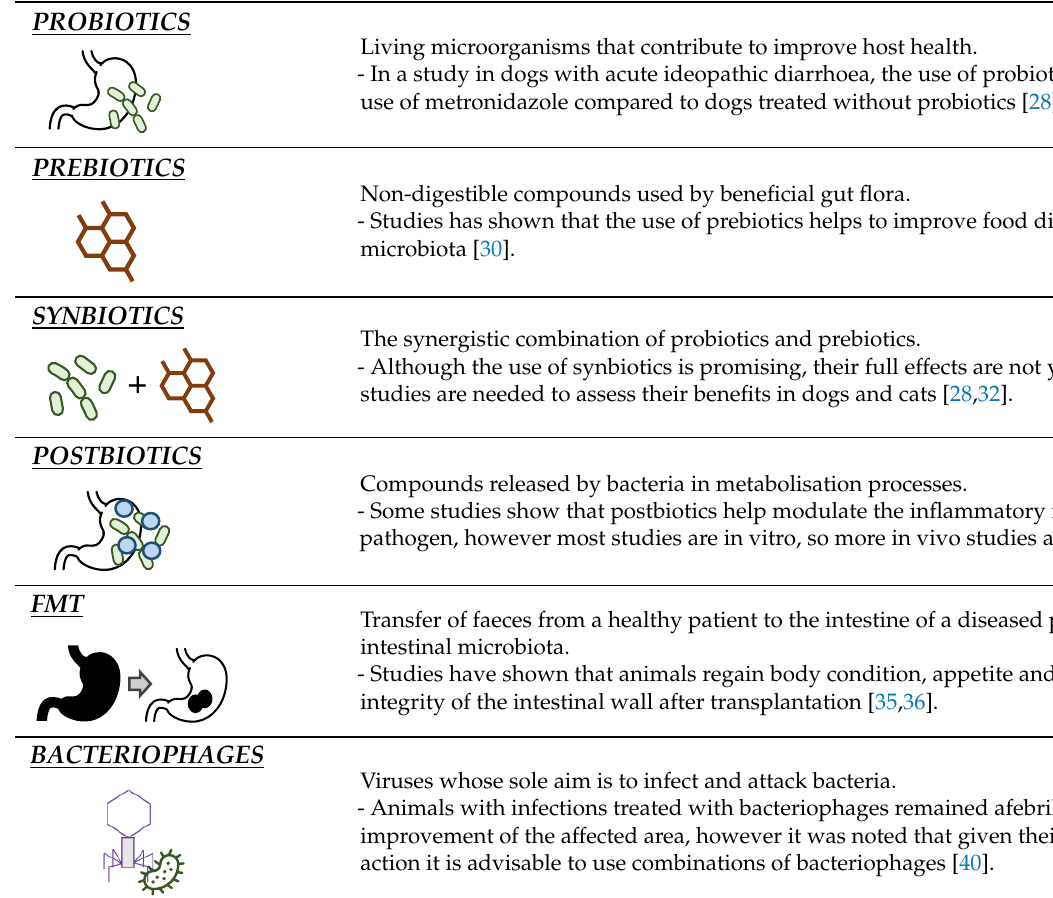
Table 1. Summary of alternatives to antibiotics in companion animals.